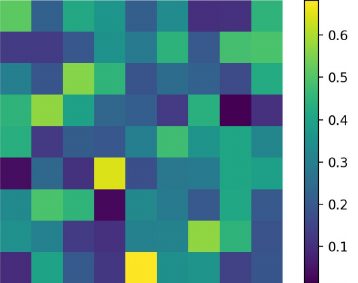
FIG. 2. Structured T-dual unitaries obtained using the M R map for d = 3. Left: a T-dual unitary consisting of three blocks (uni- tary matrices) of size 3. Right: a T-dual unitary with a 6 × 6 block and a 3 × 3